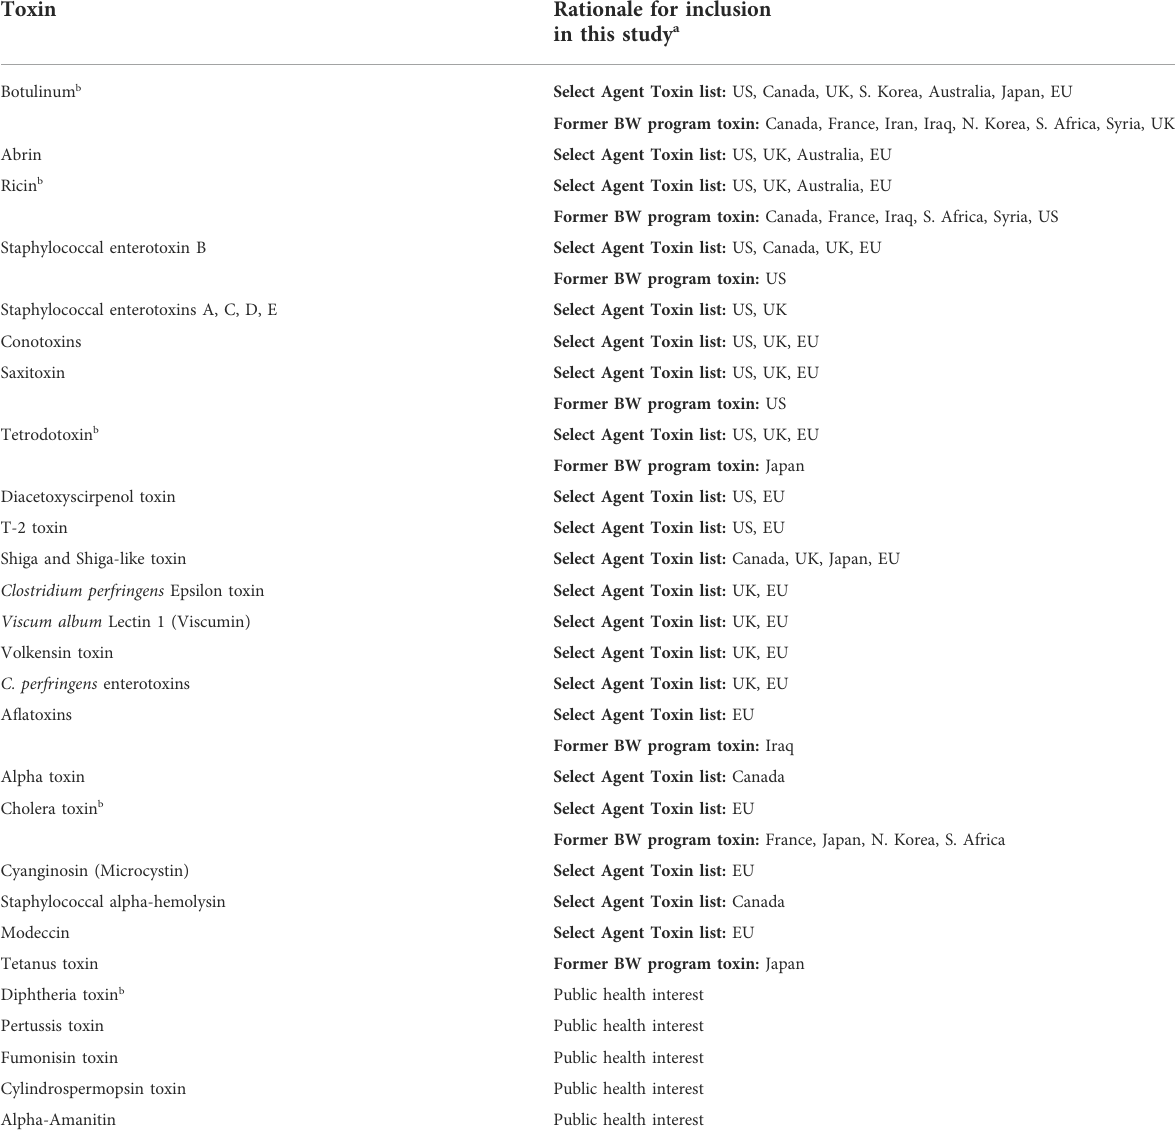
TABLE 1 Toxins included in this analysis. Toxins were chosen based on various countries ’ Select Agent Lists, inclusion in previous offensive chemical and/or biological weapons programs (Anti-terrorism, Crime and Security Act 2001, 2001; Security Sensitive Biological Agents, 2020; Security Sensitive Biological Agents and Toxins, 2021; Infectious agents and toxins, 2007; Chemical and Biological Weapons: Possession and Programs Past and Present.pdf, 2008; Risk Group Database, 2021; and Biological and chemical threats, 2014) or were otherwise of public health